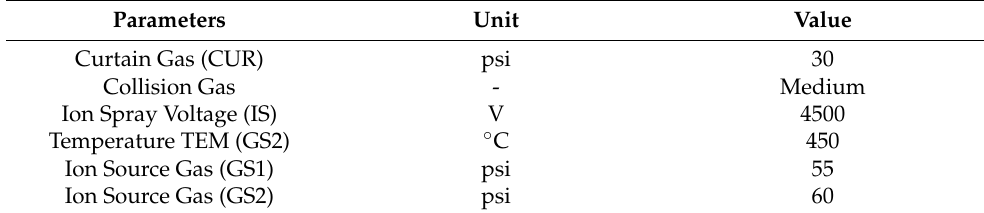
Table 1. Mass spectrometry general conditions.